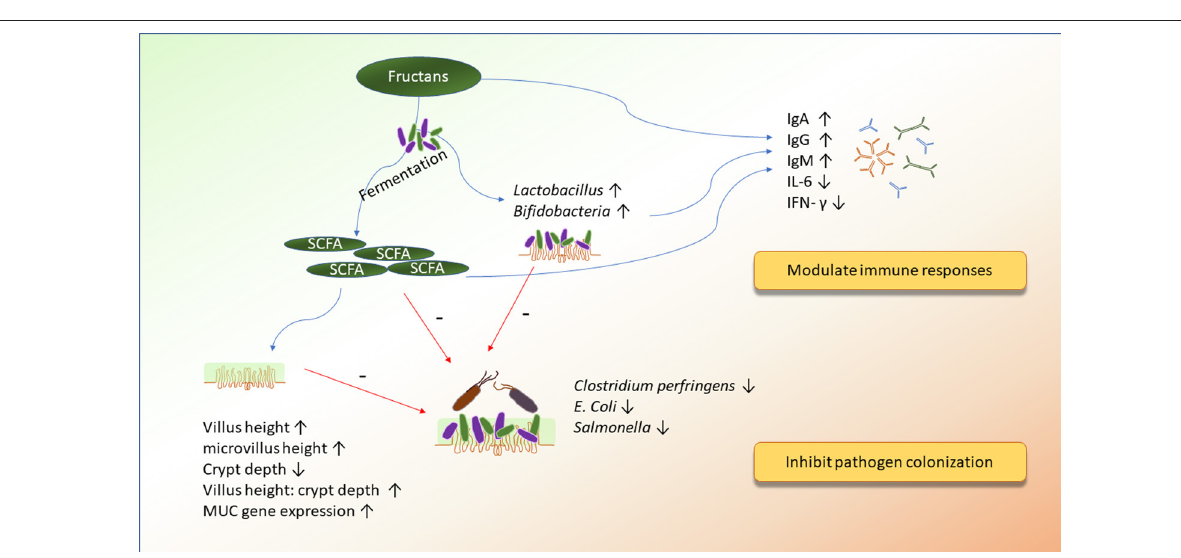
FIGURE 2 | The potential mechanisms of action of fructans on improving immunity and inhibiting pathogen